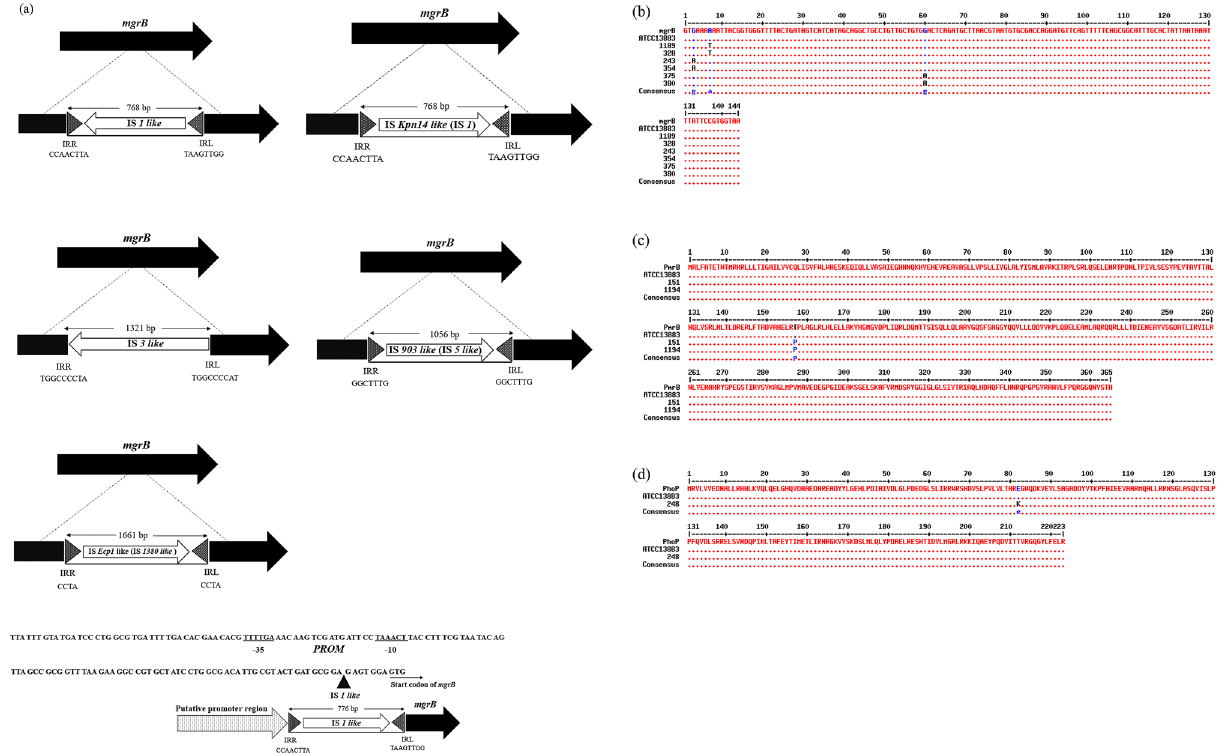
Figure 1. Chromosomal-mediated colistin-resistant mechanisms including ( a ) mgrB inactivation by different IS within the coding region and the upstream between mgrB start codon and putative promoter region of ColRkp (n = 29), ( b ) MgrB inactivation by point mutations—A7T MgrB, G3A MgrB, G60A MgrB in ColRkp (n = 6), ( c ) T157P PmrB in ColRkp (n = 2), ( d ) E82K PhoP in ColRkp (n = 1), observed in this